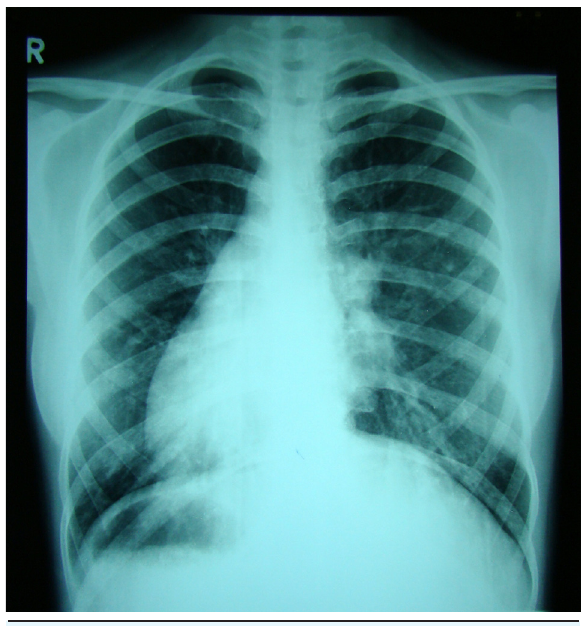
figure 1. chest X-ray image revealing dextrocardia High resolution computed tomography (HRCT) was done to visualize the bronchiectatic changes and the extent of involvement which showed dilated, fluid filled bronchi with peribronchial thickening and a ring like appearance over the bilateral lower lobes, left upper lobe and lingula (Figure 2). The lingula of the lung and heart was noted on the right side.